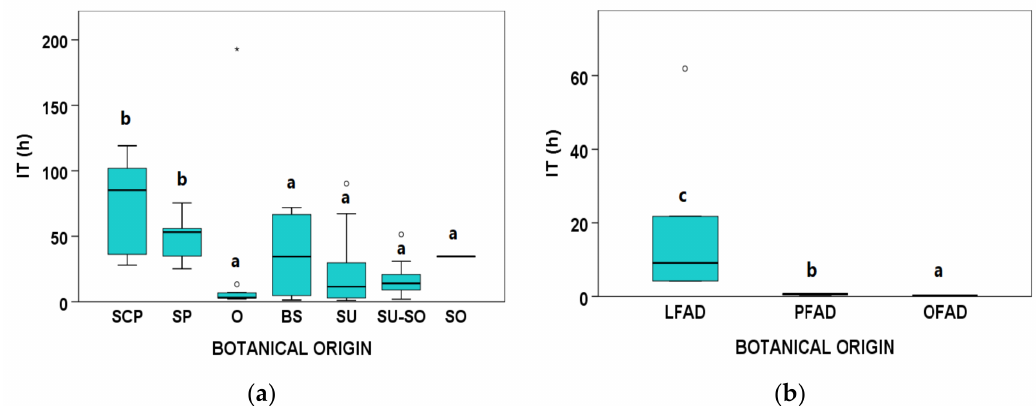
Figure 3. Boxplots for induction time (IT) measured by Rancimat at 120 °C according to botanical groups for ( a ) acid oils (AO) from chemical refining ( n = 69, because in 10 AO samples the IT could not be determined) and ( b ) fatty acid distillates (FAD) from physical refining ( n = 13) (see Table 1 for abbreviations of botanical groups). Within each type of byproduct (AO or FAD), botanical groups bearing different letters (a–c) show significantly different medians ( p ≤ 0.05) according to Kruskal–Wallis test and stepwise multiple comparisons for independent samples. ° Outliers: samples with values between (Q3 + 1.5 × IQR) and (Q3 + 3 × IQR) or between (Q1 − 1.5 × IQR) and (Q1 − 3 × IQR). * Extreme outliers: samples with values above (Q3 + 3 × IQR) or below (Q1 − 3 × IQR).